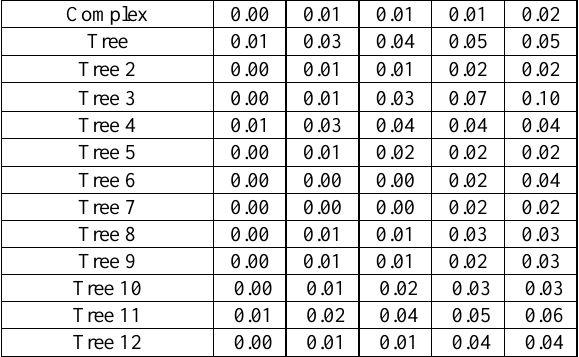
Table 2 there is little difference in curvature values between buildings and trees at all test sites. The general trend for trees is as the neighbourhood size increases the curvature value increase. However, this does not hold for buildings with simple roof structures, such as flat and ridged, having a median curvature of 0 m for all neighbourhood sizes. Whilst the median curvature of